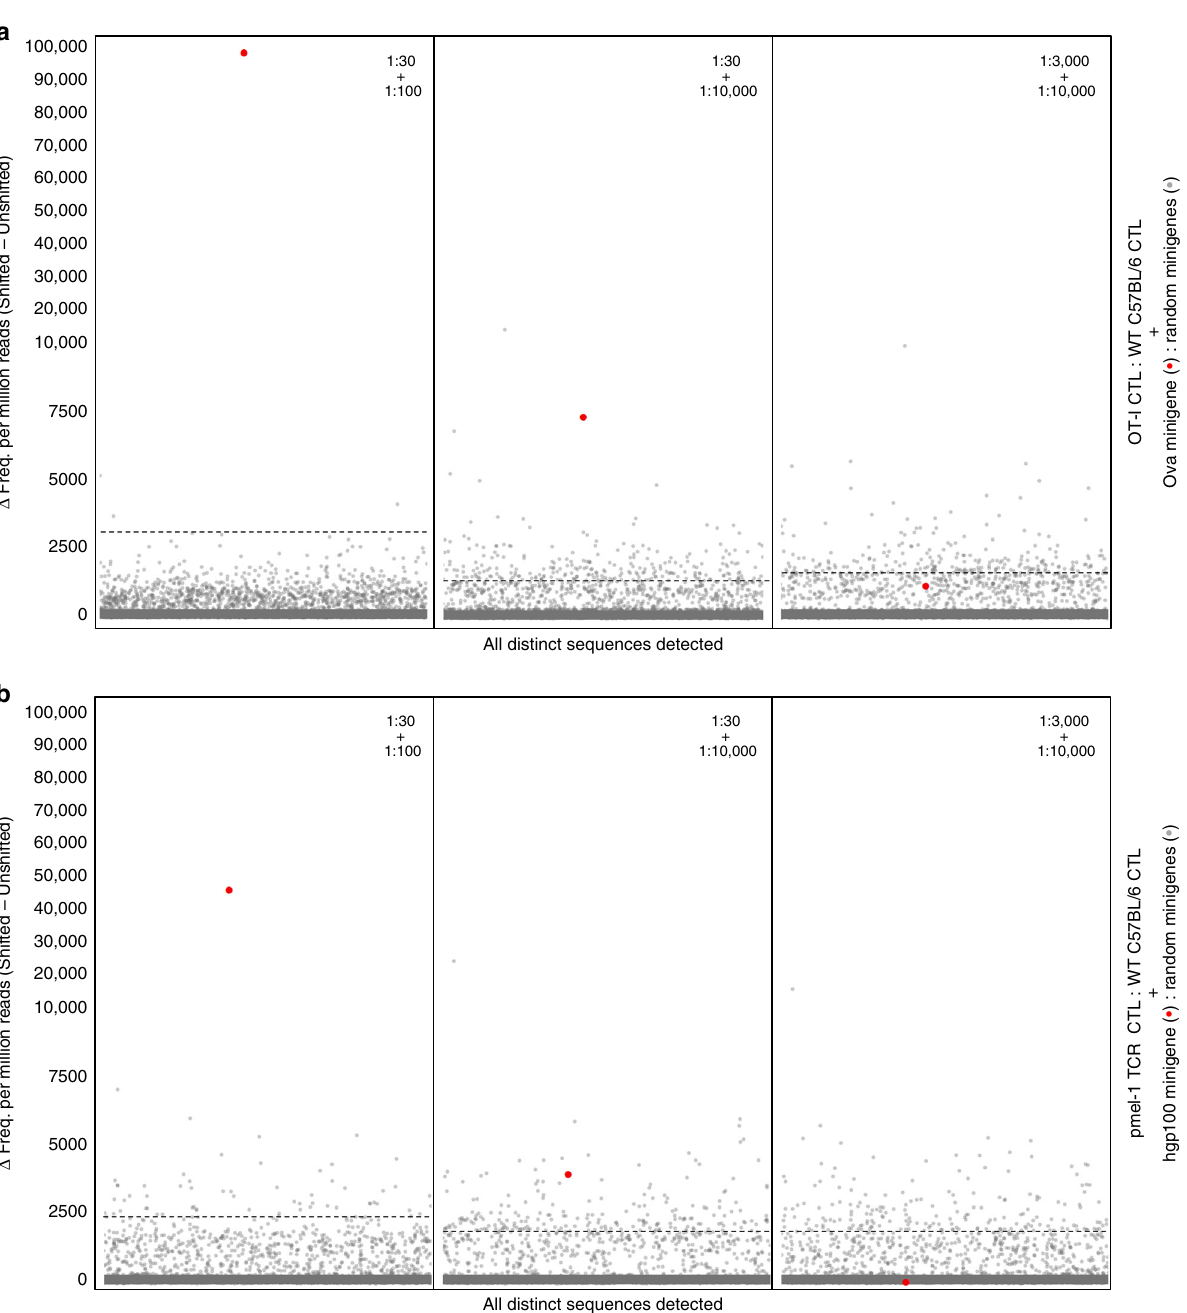
Fig. 5 Screening co-cultures of mixed CTL populations + mixed target cell populations. Random minigene cell libraries spiked with either Ova minigene- expressing cells or hgp100 minigene-expressing cells were co-incubated with wild-type C57BL/6 CTL spiked with OT-I or pmel-1 TCR CTL, respectively. The speci fi c mixtures used for testing are described in panel headers. Target and CTL populations were combined at a 1:1 ratio and co-cultured for 4 h before being sorted on FRET-shift status. Recovered cells from Shifted and Unshifted gates from each screening condition were lysed, and integrated minigenes were ampli fi ed from genomic DNA using PCR primers speci fi c for the conserved transgene region fl anking the minigene site. Illumina adapters and indexes were added in a second round of PCR, and resultant amplicons were sequenced on the Illumina MiSeq platform with 2 × 250 paired-end chemistry. a The differences in relative abundance for all distinct minigene sequences detected in the Shifted gates and the Unshifted gates of OT-I/Ova minigene mixtures. b The differences in relative abundance for all distinct minigene sequences detected in the Shifted gates and the Unshifted gates of pmel-1 TCR/hgp100 minigene